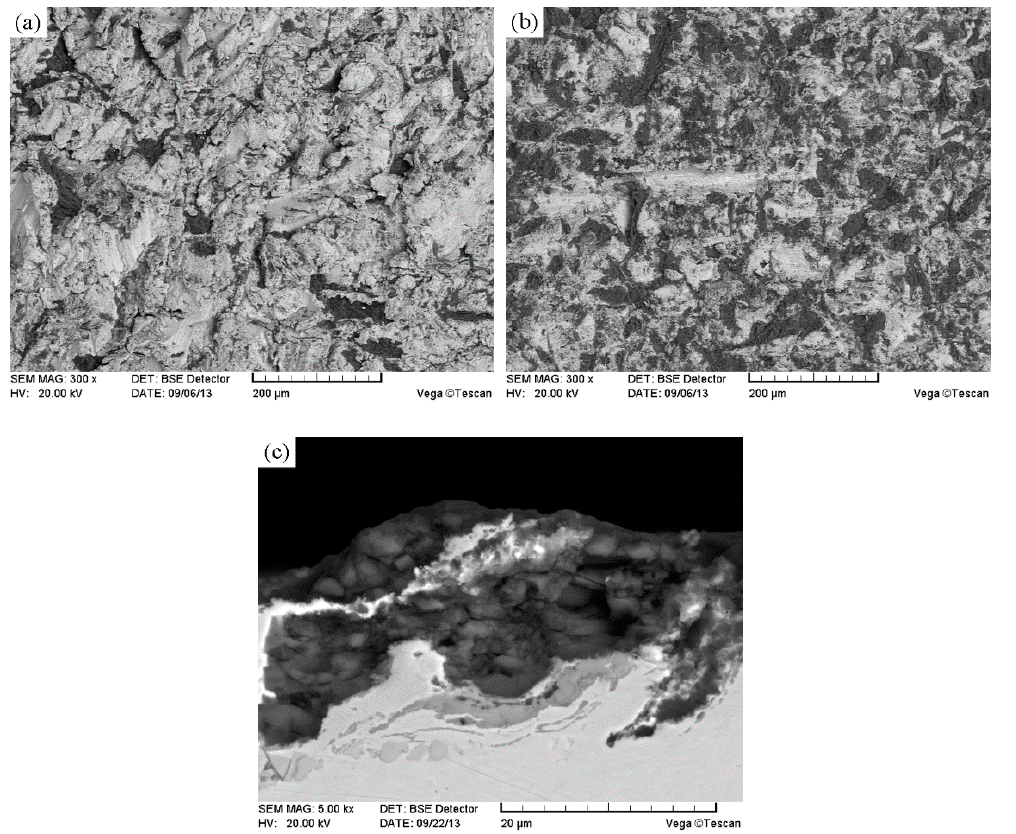
Figure 18. Worn surface morphologies of the substrate regions: ( a ) at RT; ( b ) at 600 °C; and ( c ) cross-section morphology of the substrate region at 600 °C.